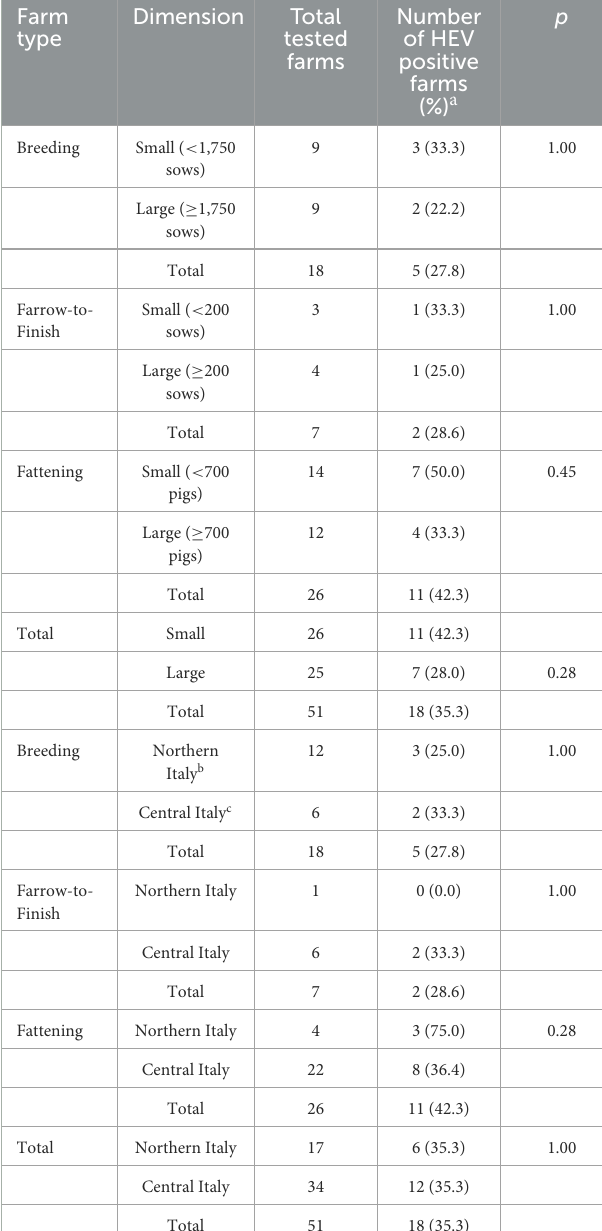
TABLE 1 HEV positive farms grouped by type, size and geographic